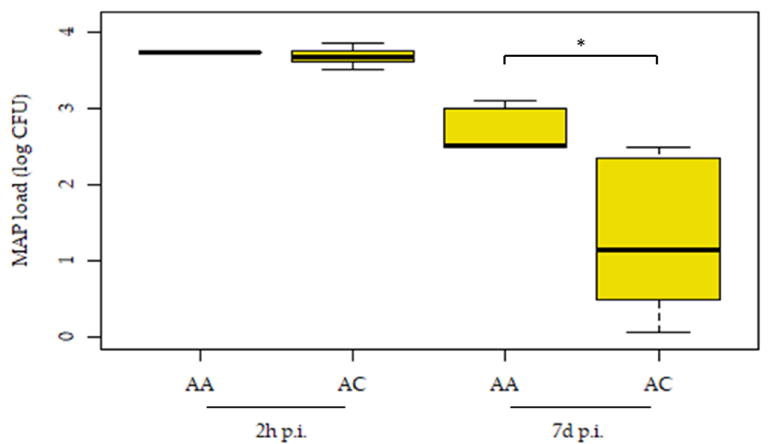
Figure 2. Host MDMs expressing the cis-eQTL-rs41976219 AC genotype show an increased ability to control MAP infection. MDMs purified from PB of cows with the homozygous (AA, N = 5) and heterozygous (AC, N = 11) genotypes for the rs41976219 and infected ex vivo with MAP. Intracellular bacterial load estimated at 2 h and 7 days p.i. The median and upper and lower quartiles of each group are represented by horizontal and vertical lines, respectively. The lowest point is the minimum of the dataset and the highest point is the maximum of the dataset. p -values are calculated using an unpaired t-test. * p -value ≤ 0.05.